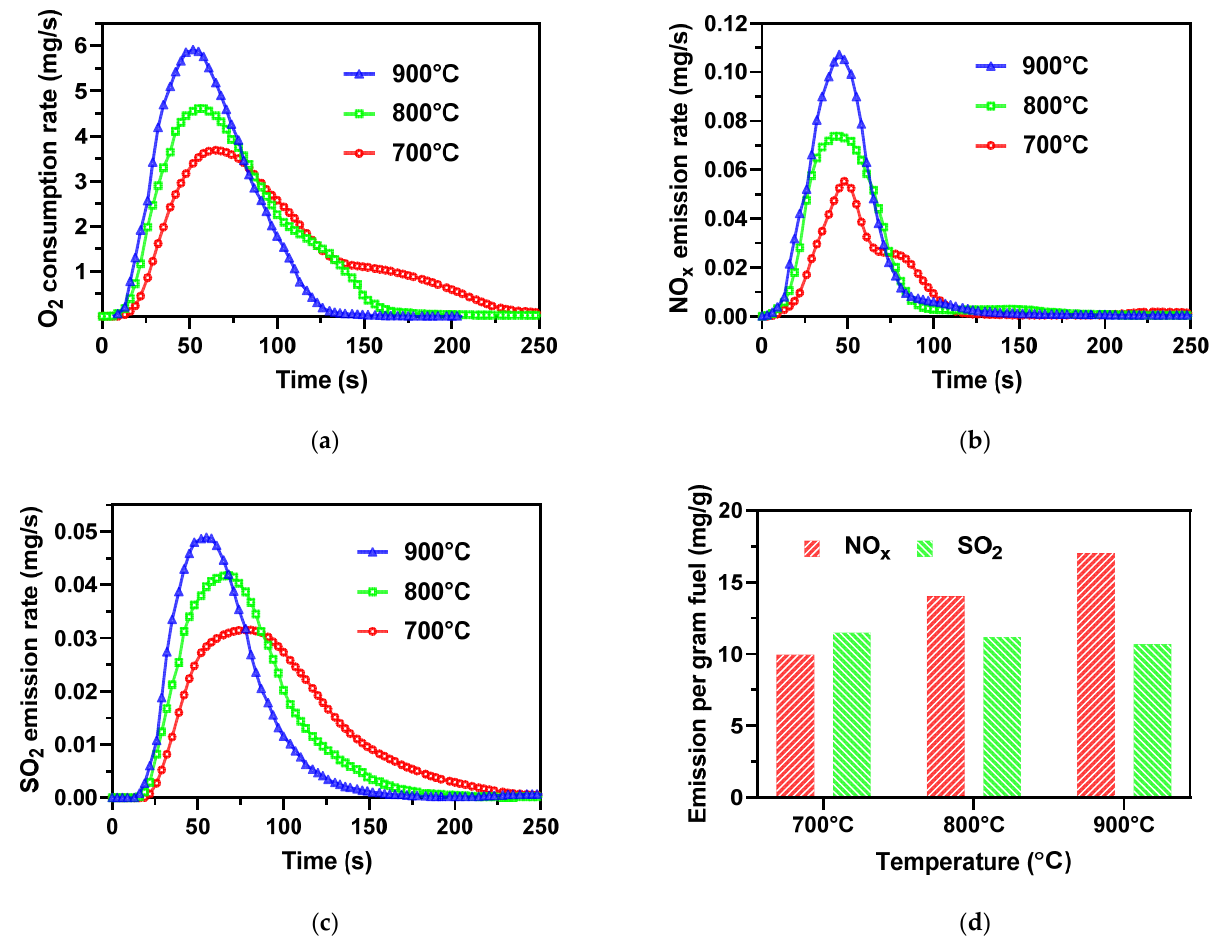
Figure 4. ( a ) O 2 consumption, ( b ) NO x emission, ( c ) SO 2 emission as a function of time during combustion of the AMR, and ( d ) NO x and SO 2 emissions per gram AMR at different combustion temperatures. Table 4. The time of curve peak, t max , under various combustion conditions for O 2 consumption, NO x emission, and SO 2